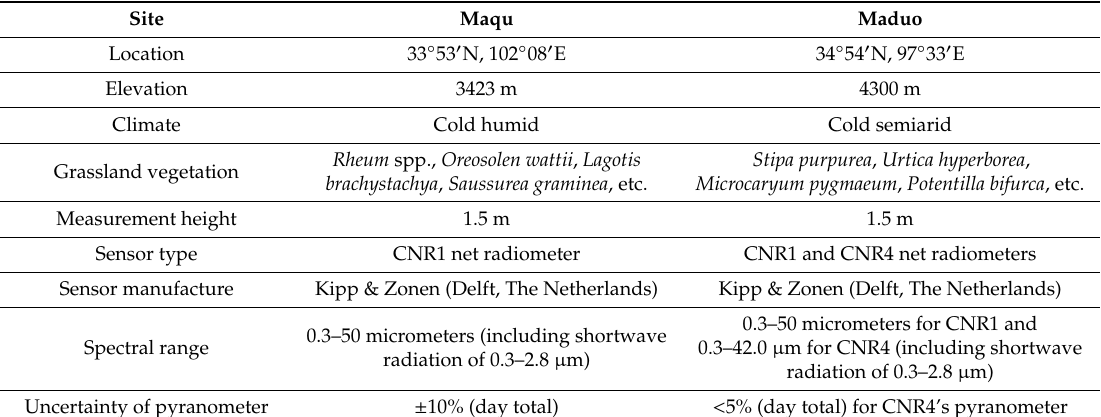
Table 2. Basic information of ground measurement sites and specific parameters of observational